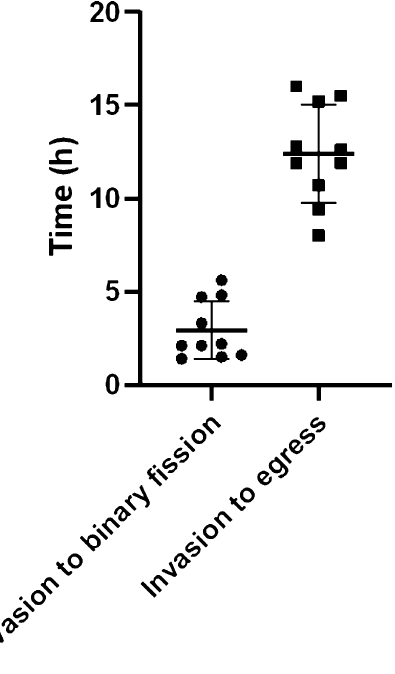
Figure 1. Time-lapse imaging of B. bovis . GFP-expressing B. bovis merozoites were observed over 24 h period and events following parasite egress and subsequent invasion were witnessed (n =